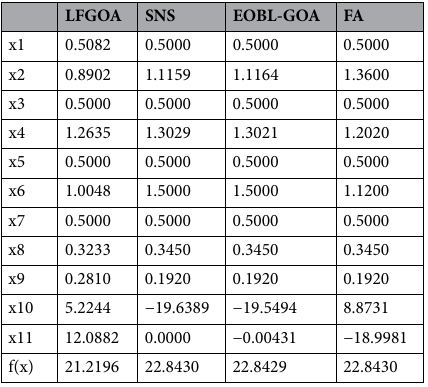
Table 19. The optimum values of the car side impact design example.